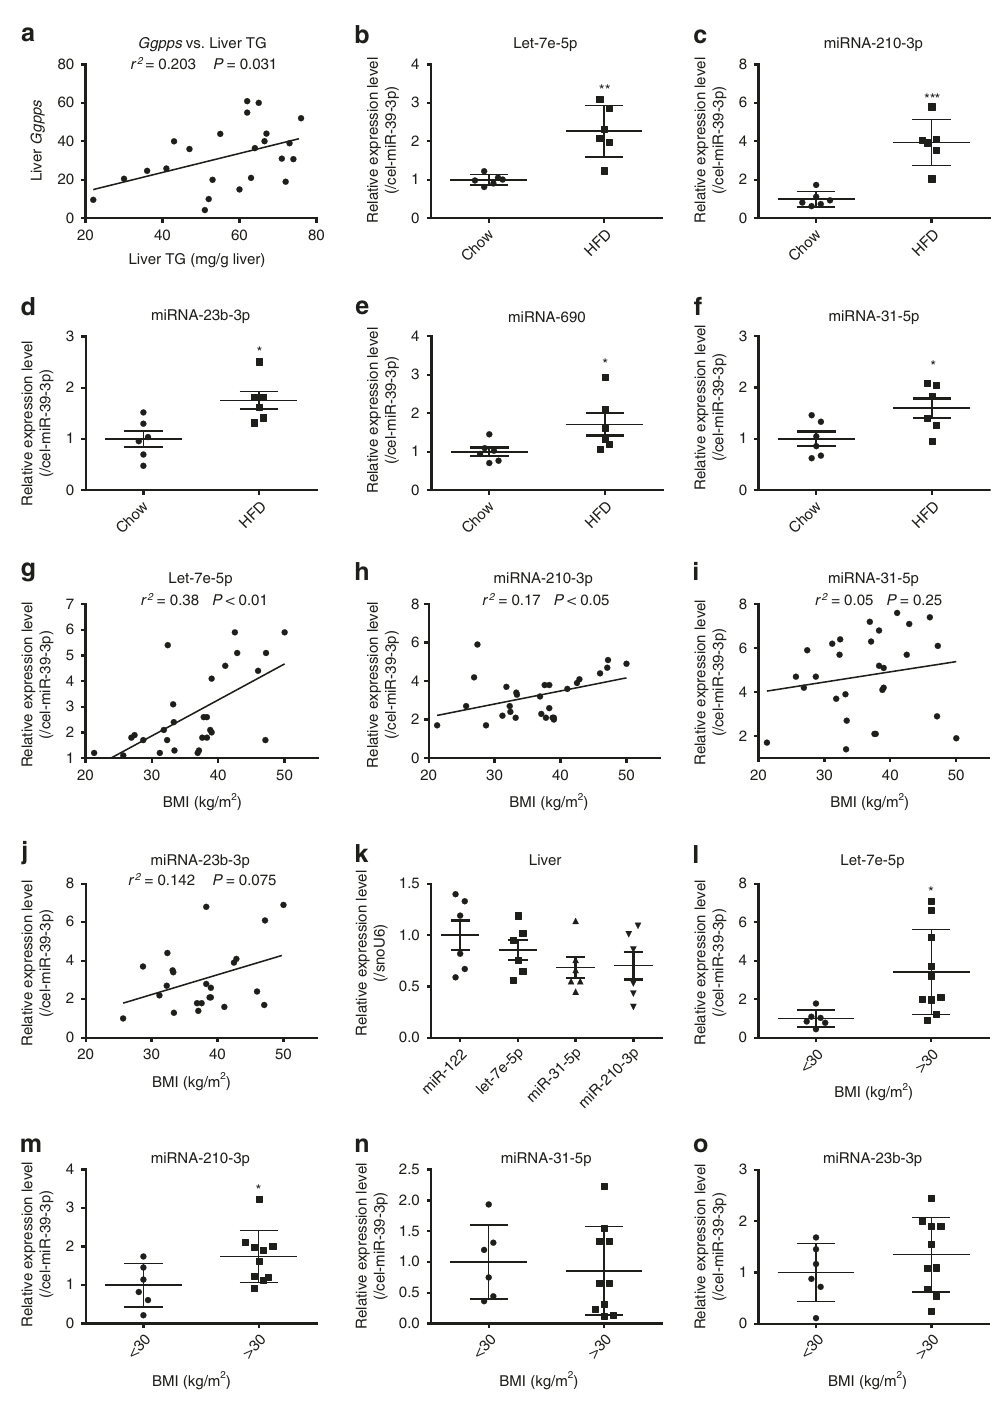
Fig. 7 Ggpps mRNA levels and MiRNA levels of EVs in mice and patients. a Linear regression analysis between liver TG count and Ggpps mRNA levels in patients ( n = 23 samples). b – f The levels of let-7e-5p, miR-210-3p, miR-23b-3p, miR-690 and miR-31-5p among the plasma EVs of mice fed a normal chow diet and a HFD. The relative values refer to the fold change of each miRNA in HFD-EVs compared with that in Chow-EVs. ( n = 6 mice per group). g – j Linear regression analysis between BMI and let-7e-5p, miR-210-3p, miR-31-5p and miR-23b-3p levels in plasma EVs from patients ( n = 28 samples). k The relative expression levels of miR-122, let-7e-5p, miR-210-3p and miR-31-5p in the livers of patients. The relative values refer to the fold change of let-7e-5p, miR-210-3p and miR-31-5p levels compared to miR-122 levels ( n = 6 samples). l – o Let-7e-5p, miR-210-3p, miR-31-5p and miR-23b-3p levels in the plasma EVs of NAFLD patients with a BMI < 30 or > 30. The relative values refer to the fold change of each miRNA in EVs from patients with BMI > 30 patients compared with that in EVs from patients with BMI < 30. (BMI < 30: n = 6 samples; BMI > 30: n = 10 samples). Data are presented as the mean ± SD. * P < 0.05, ** P < 0.01, *** P < 0.001, ( a , g , h , i , j ) linear regression analysis; ( b , c , d , e , f , l , m , n , o ) unpaired t test. Source data are provided as a Source Data fi le. See also Supplementary Table